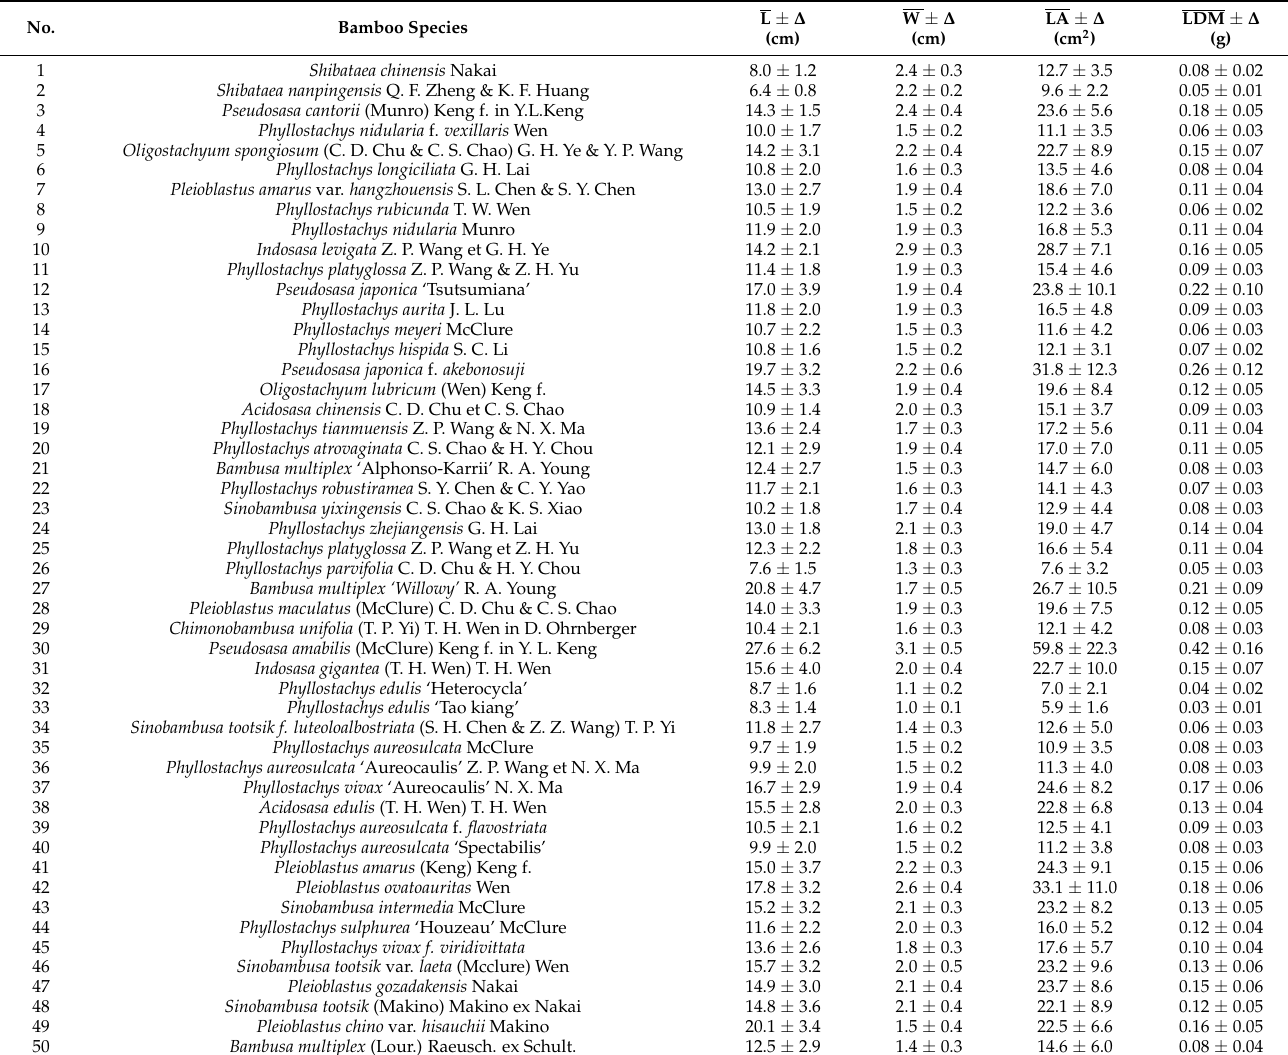
Table A1. The mean values of the measured leaf parameters, leaf area and leaf dry mass of the 50 bamboo species. L, W, LA, and LDM are the mean values of leaf length, leaf width, leaf area, and leaf dry mass, respectively. ∆ is the standard